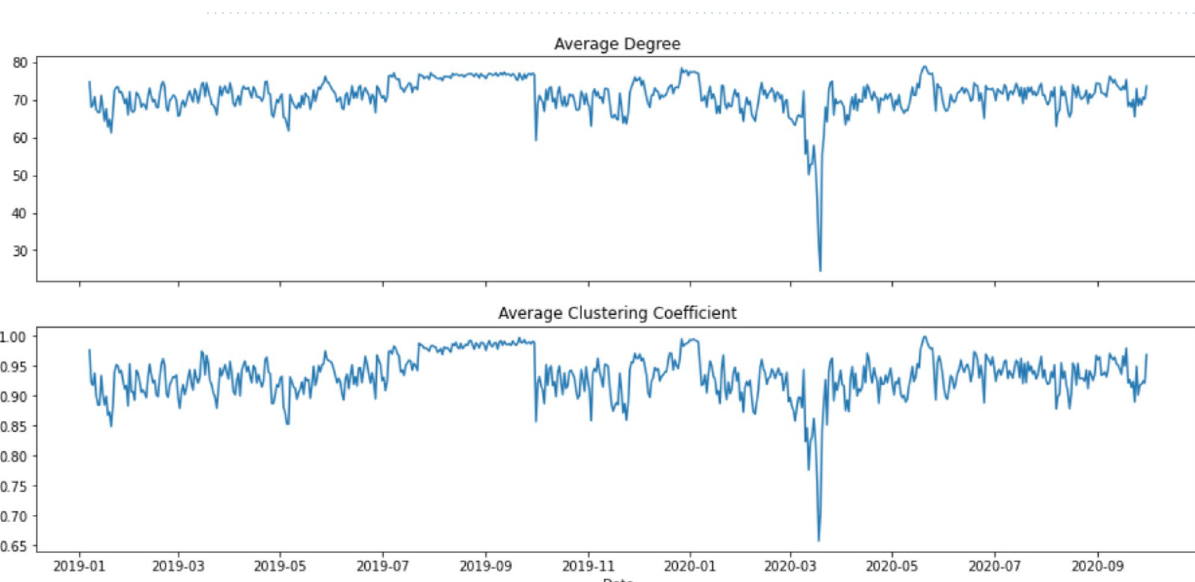
Figure 4. Network statistics, 1 January 2019 to 30 September